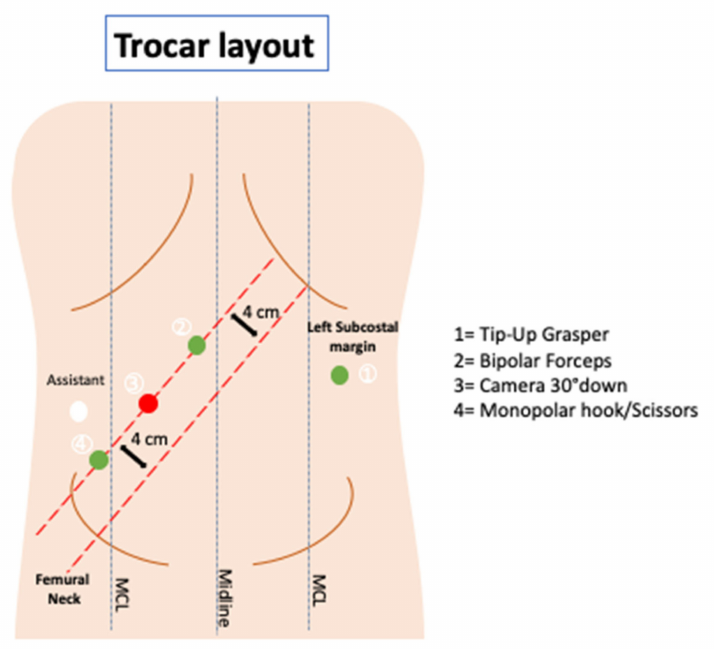
Figure 1. Trocar layout.